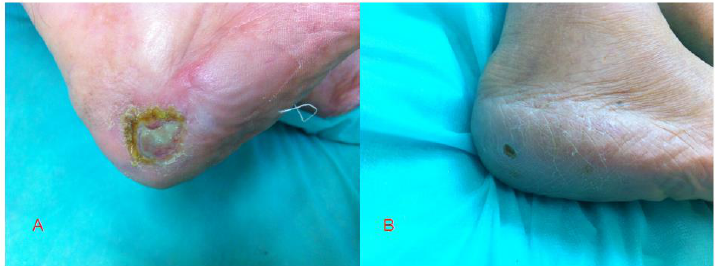
Figure 3. Ulcer healing in a Group 1 patient ( A ) before treatment and ( B ) after 3 months.